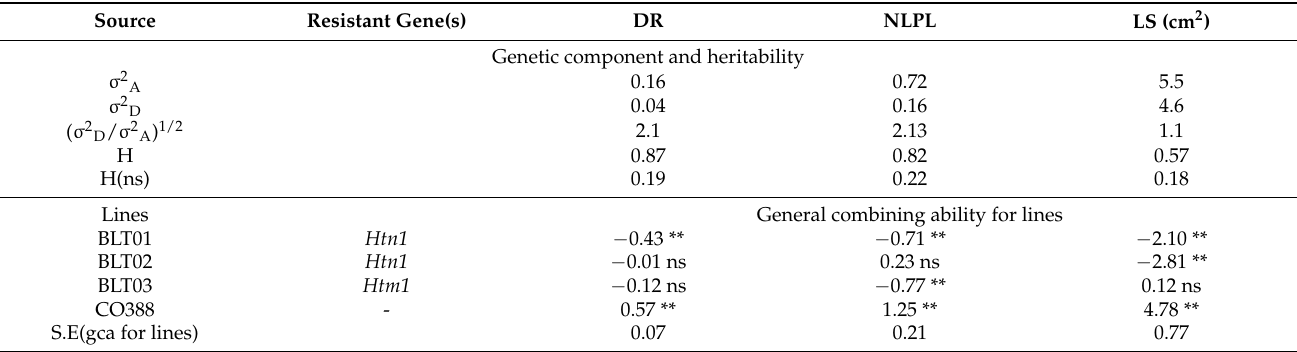
Table 3. Genetic component, heritability (H), and heritability in the narrow sense (H(ns)), and general combining abilities of CO388-related Line × Tester analysis for disease rating (DR), number of lesions per leaf (NLPL), and lesion size (LS, cm 2 ) under artificial inoculations of northern corn leaf